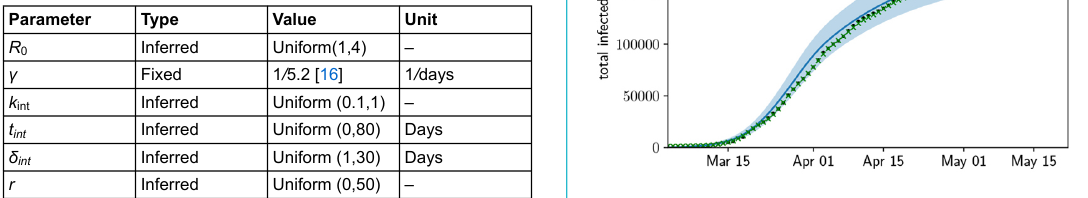
Table 1: Parameters and the prior distributions for the model dis- cussed in the section “Epidemic modelling using the SIR”. Parameter Type Value